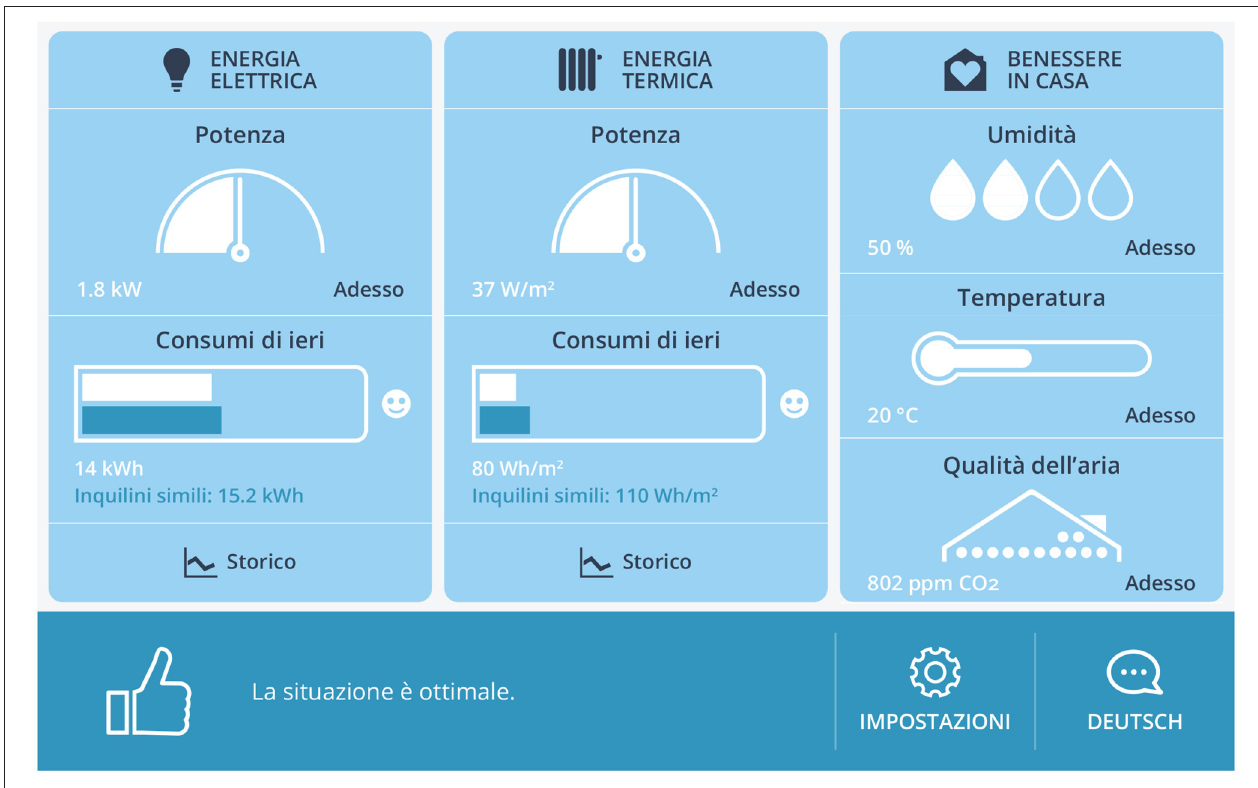
FIGURE 3 | Norms group home